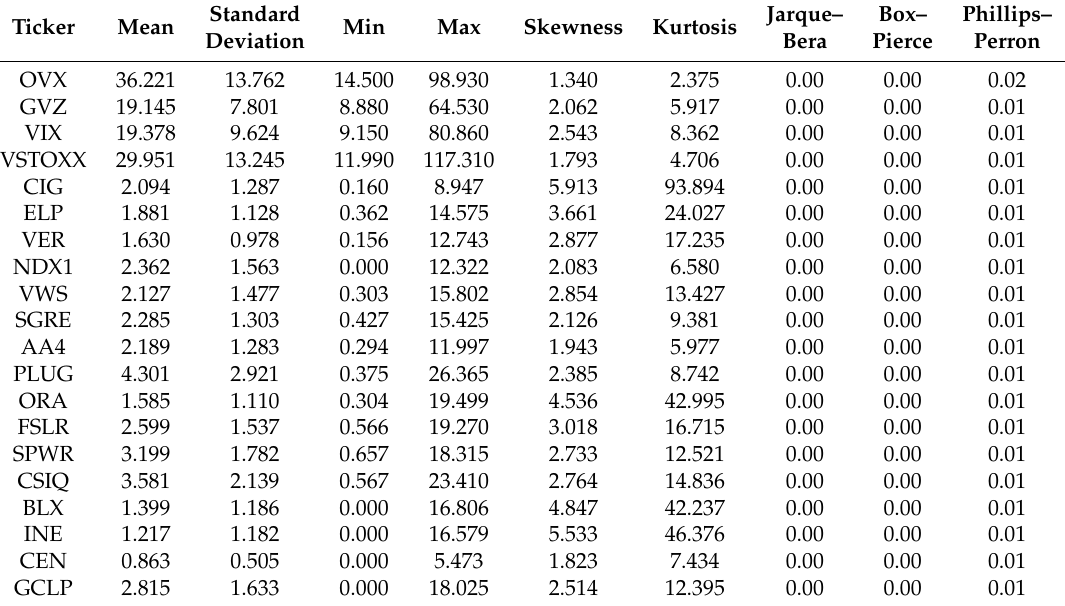
Table 3. Descriptive statistics of daily implied volatility indices and realized volatility